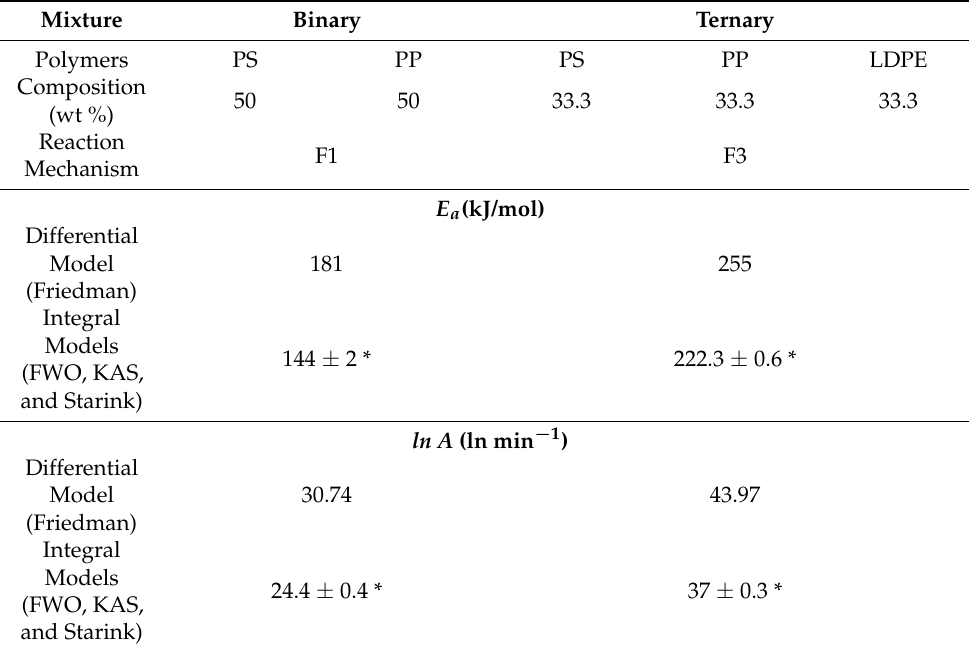
Table 11. Kinetic parameters of the pyrolysis of mixed polymers. Mixture Binary Ternary